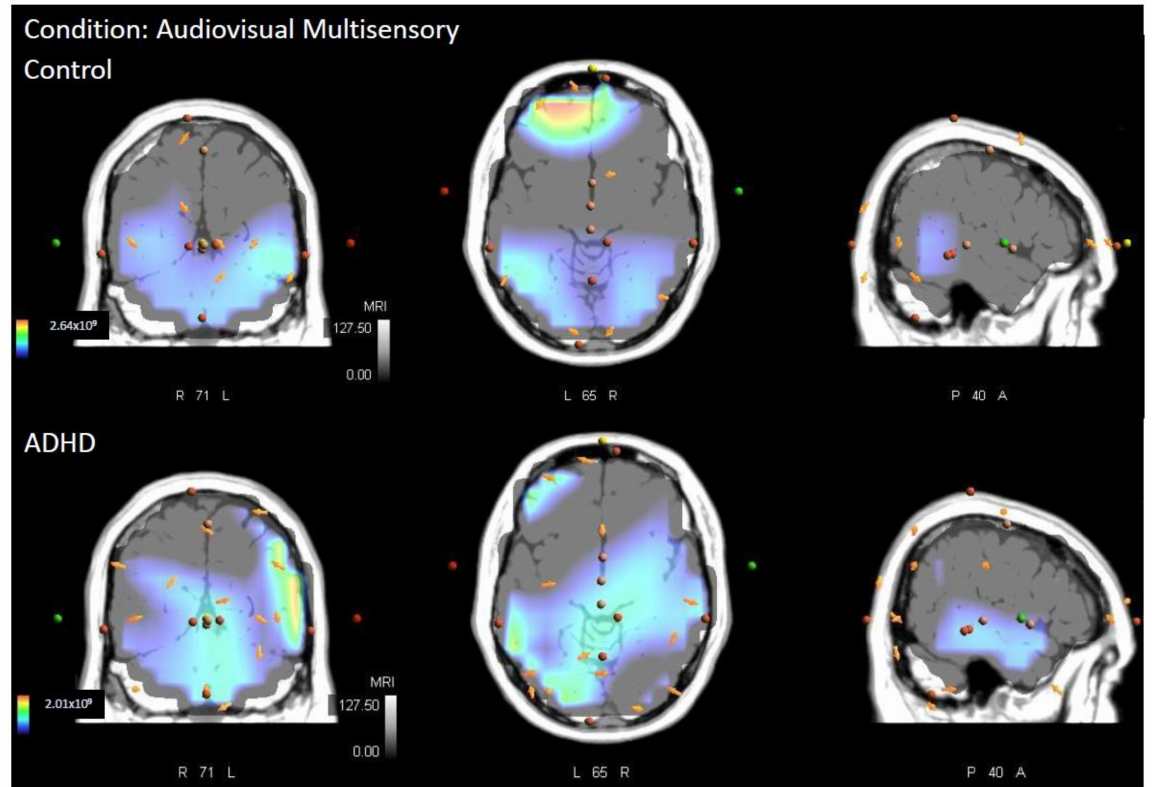
Figure 4. Average sources of neural activity for the audiovisual multisensory for each group (ADHD and Control) at 164 ms post stimulus onset. From left to right is the coronal ( left ), transverse ( middle ), and sagittal plane ( right